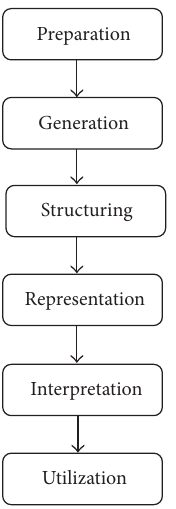
Figure 1: Steps involved in concept mapping